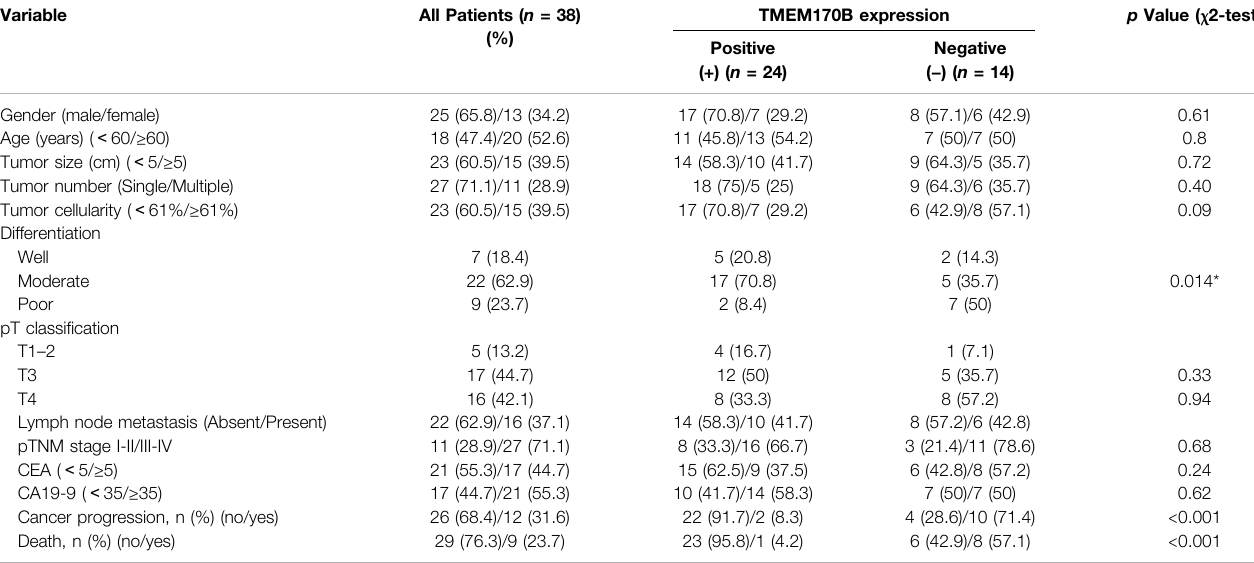
TABLE 1 | Association between TMEM170B expression and clinicopathological characteristics in 38 pancreatic adenocarcinoma patients.